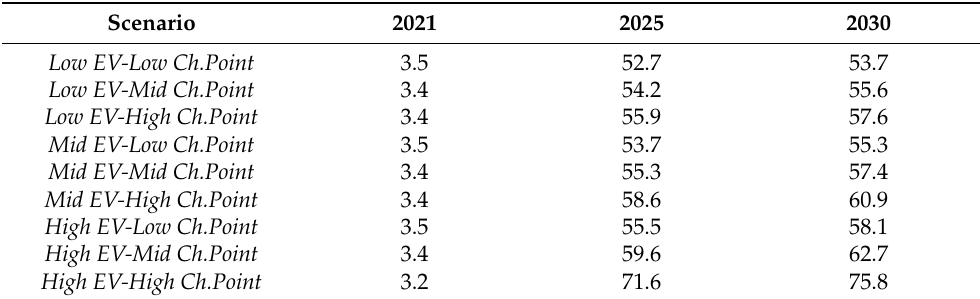
Table 11. Cumulative government expenditures for infrastructure investments and subsidies in